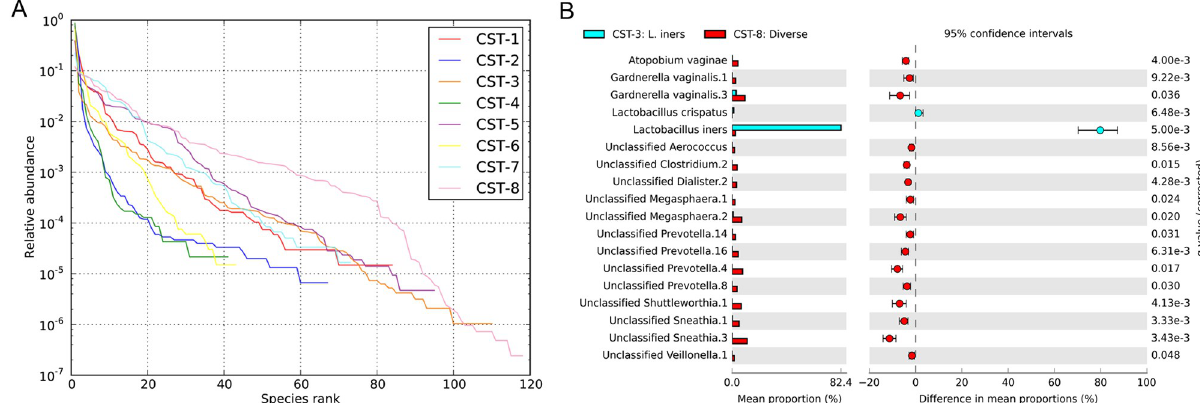
Fig 2. Diversity and composition of the cervicovaginal microbiota. (A) Rank abundance plots of bacterial taxa in the eight established community state types. Rank abundance plots were used to estimate the bacterial diversity by measuring richness, dominance, and evenness. Richness is the distance a curve extends along the x-axis while dominance is the y-intercept. A higher value on the y-axis depicts increased dominance; hence, low diversity. Evenness is indicated by a low slope of the curve. Therefore, in a rank abundance plot, a high dominance, more richness and evenness in a bacterial community indicate a high ecological diversity. (B) STAMP extended error bar plots depicting enriched bacterial taxa in two community state types. Only features with greater than zero difference between their percentage proportions in CST-3 and CST-8 with an effect size � 1.0 and q-value < 0.05 are shown. The statistical comparison was carried out in STAMP. The p-values (adjusted by Benjamini-Hochberg correction to account for false discovery rates), effect size and CI (0.95, DP: bootstrap) computed by White’s non-parametric t-test (two-sided type) are indicated. The difference in mean proportions and 95% CI are shown on the bar plots.